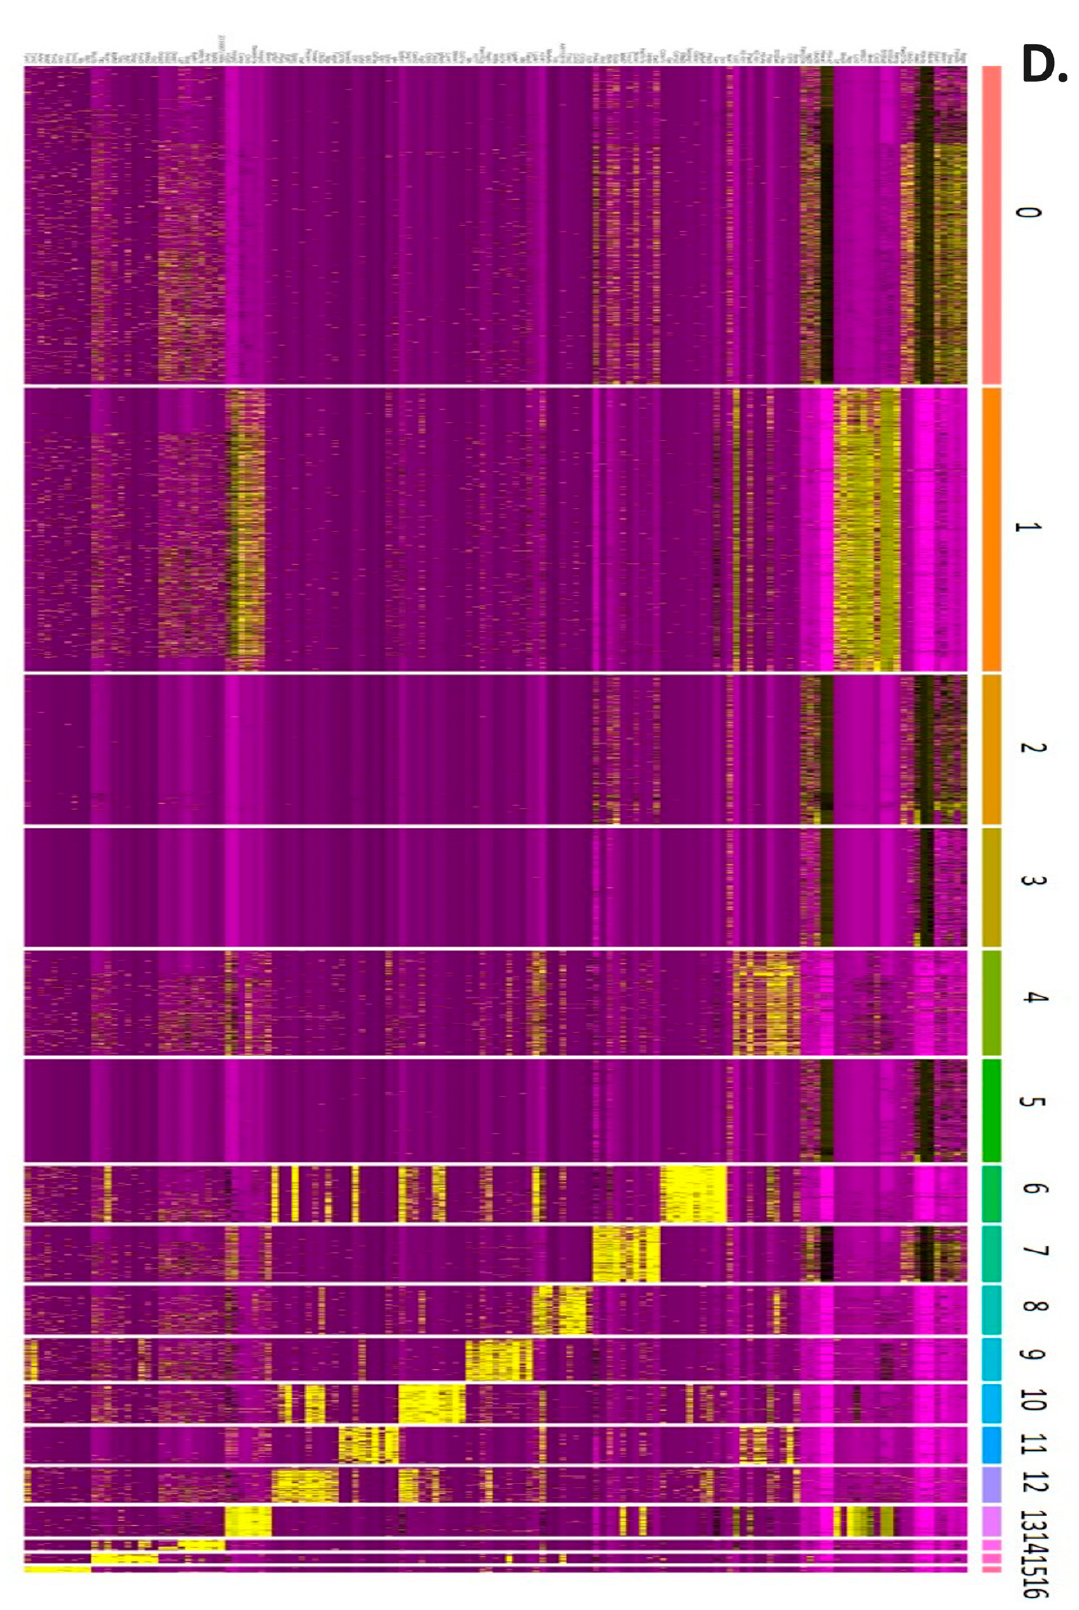
Figure 2. Visual distribution of dimensionality reduction in cell populations. ( A ) The cell distribution of all samples generated through t-distributed stochastic neighbor embedding and t-random neighbor embedding, with four groups as the source (16- and 29-week control and experimental groups). ( B ) Cells divided into 17 subtypes by using the Louvain algorithm. ( C ) Separation of the four major groups of cell populations and the distribution of the 17 cell subtypes. ( D ) Heat map of the 17 cell